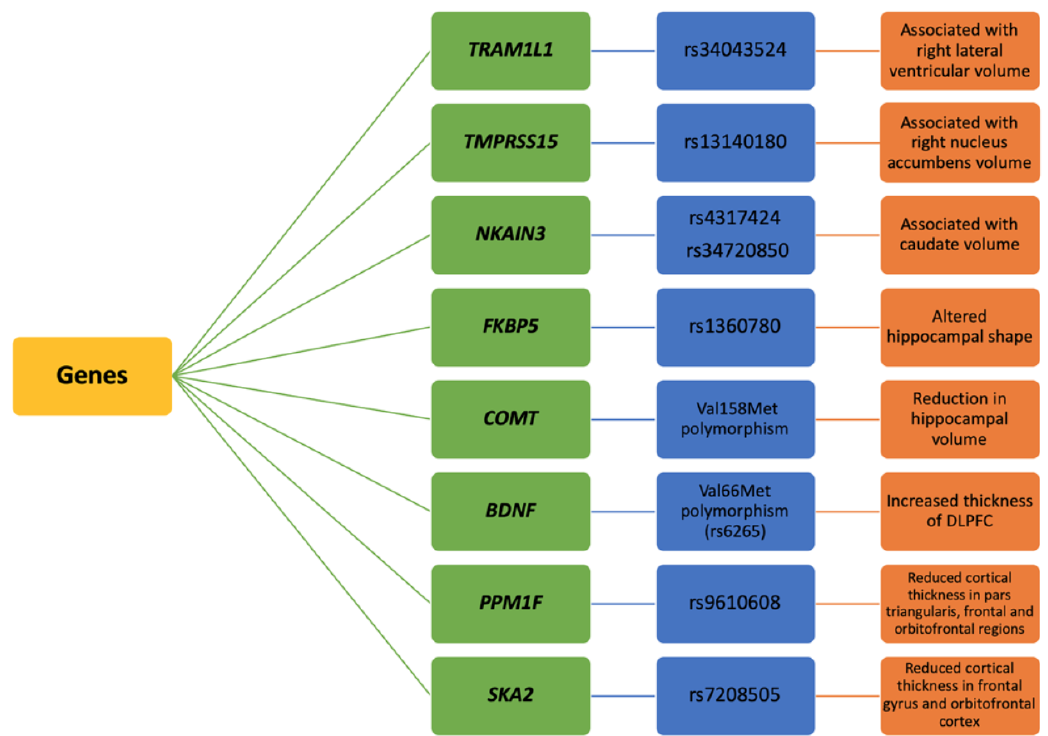
Figure 5. Genes associated with the structural brain changes in PTSD. TRAM1L1 , TMPRSS15 , NKAIN3 , FKBP5 , COMT , BDNF , PPM1F , and SKA2 are the most reported genes that affected the brain morphology in PTSD .